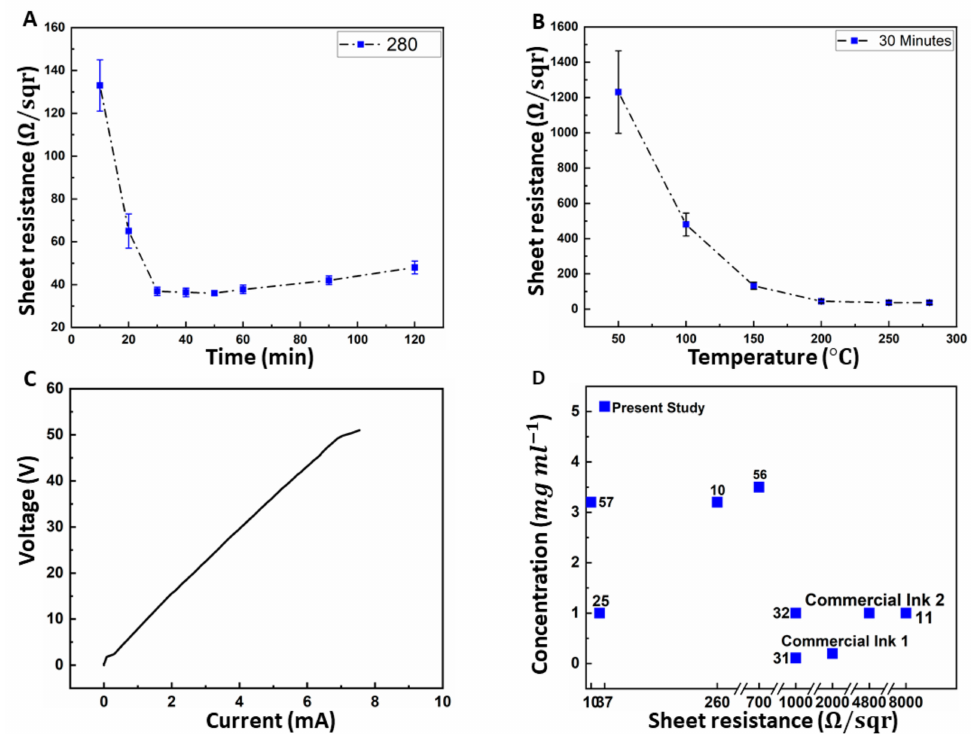
Figure 5. ( A ) Change of sheet resistance R S of printed graphene with respect to annealing time in 280 ◦ C oven. ( B ) Change of the sheet resistance of printed graphene with respect to changes in annealing temperature. ( C ) Linear I–V response of the lines with length of 100 mm measured by a potentiostat. ( D ) Comparison of the yield and resultant sheet resistance of produced graphene with other